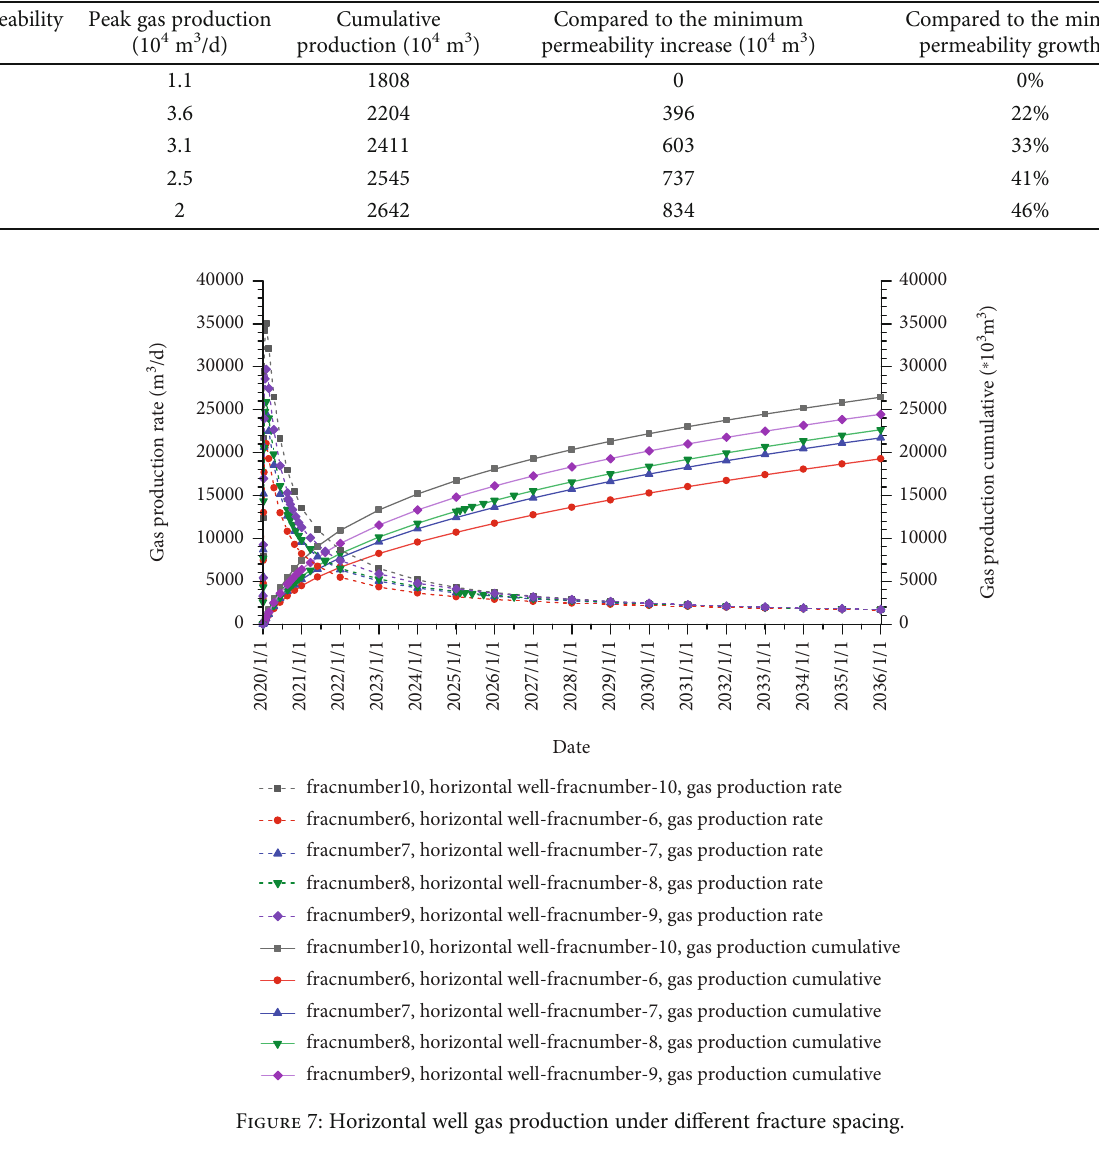
Table 5: Peak and cumulative gas production at di ff erent permeability levels.